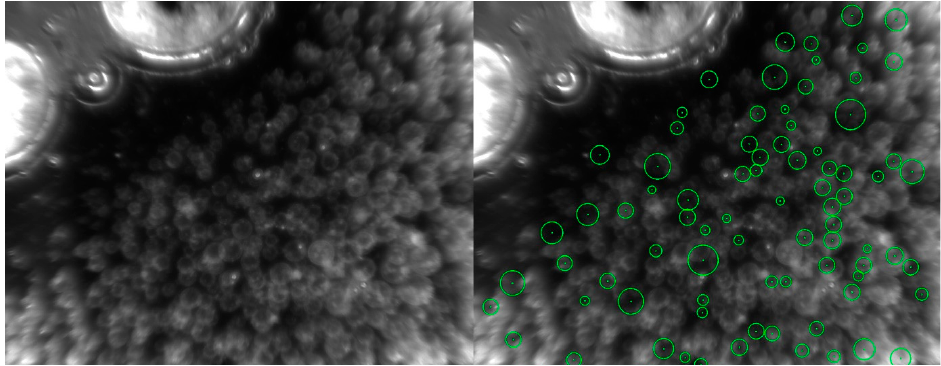
Figure 24. Acquisition of the droplets ( left ) and evaluation of the image ( right ) by the SOPAT-PA probe and the SOPAT algorithm.